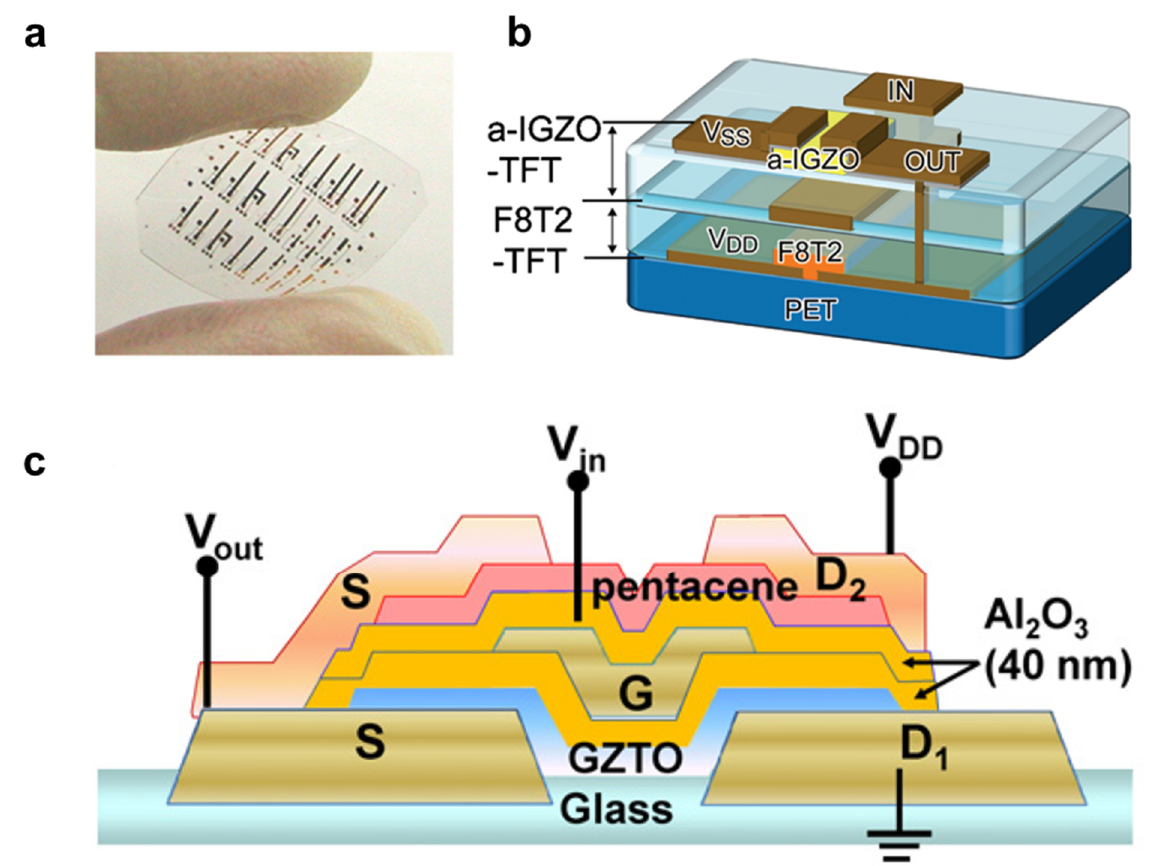
Figure 7. ( a ) Image of the flexible hybrid inverter comprising n -type IGZO TFT and p -type F8T2 TFT and that of ( b ) the device structure (adapted from [122] with permission from American Institute of Physics). ( c ) Illustration of a cross-section view of the Vs-CTFT inverter with n -type GZTO TFT and p -type pentacene TFT (adapted from [118] with permission from Elsevier